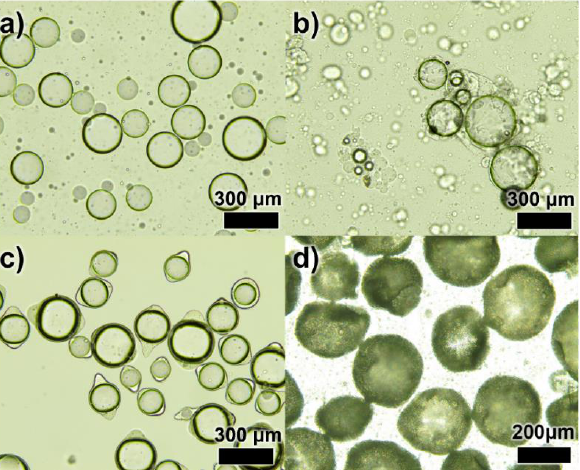
Figure 2. Optical images of the microencapsulation process; ( a ) an emulsification step, ( b ) a complex coacervation step, ( c ) a crosslinking step and ( d ) UF resin coated DL-MCs.